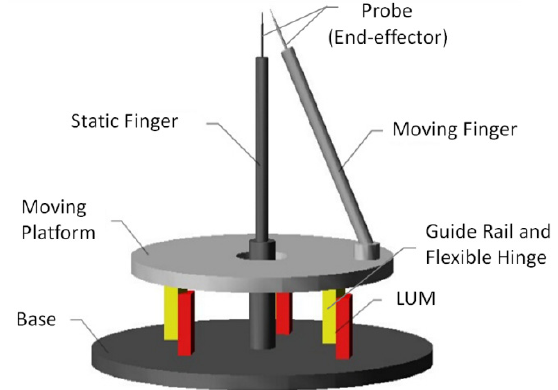
Figure 1. Structure of the microgripper.